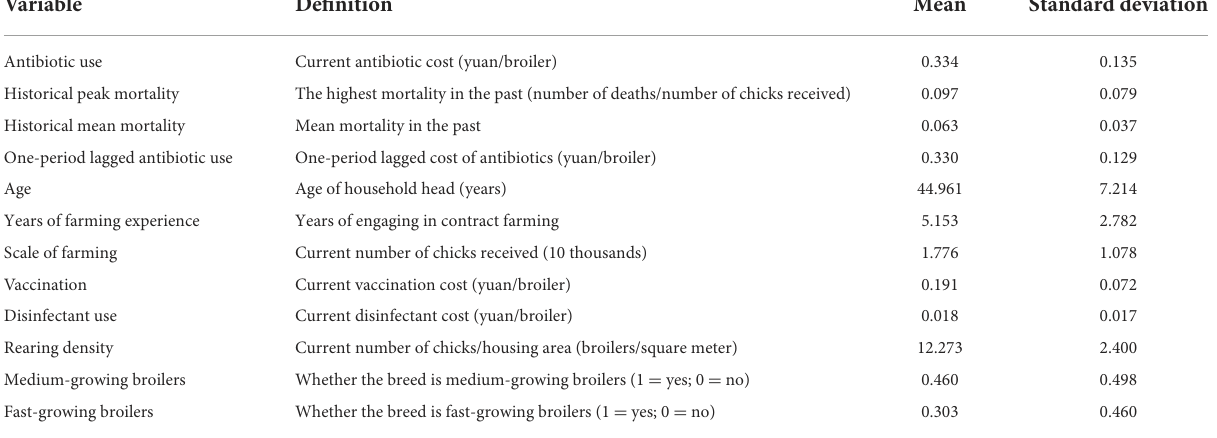
TABLE 1 Variable definitions and descriptive